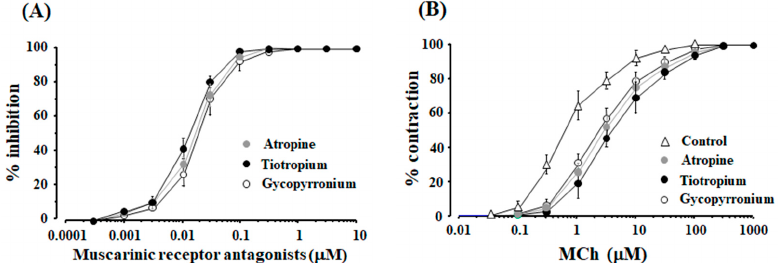
Figure 3. Effects of a muscarinic receptor antagonist on muscarinic contraction via orthosteric sites. ( A ) Concentration-inhibition curves for atropine, tiotropium and glycopyrronium against MCh (10 μ M); ( B ) Concentration-response curves for MCh (control) in the absence and presence of atropine, tiotropium and glycopyrronium (each 10 nM). MCh: methaxholine. Table 1. Pharmacological characteristics of muscarinic receptor antagonists.